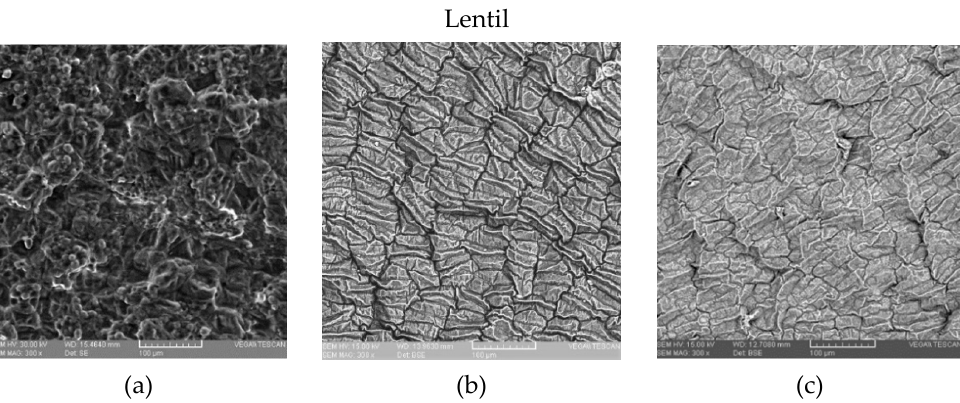
Figure 2. Scanning electron microscope (SEM) images showing the microstructures of legumes during germination: ( a ) nongerminated; ( b ) germinated 2 days; ( c ) germinated 4 days.